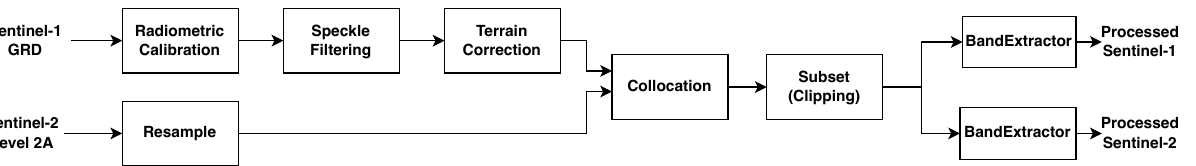
Figure 1. Snap processing pipeline for Sentinel-1 Ground Range Detected (GRD) and Sentinel-2 Level-2A